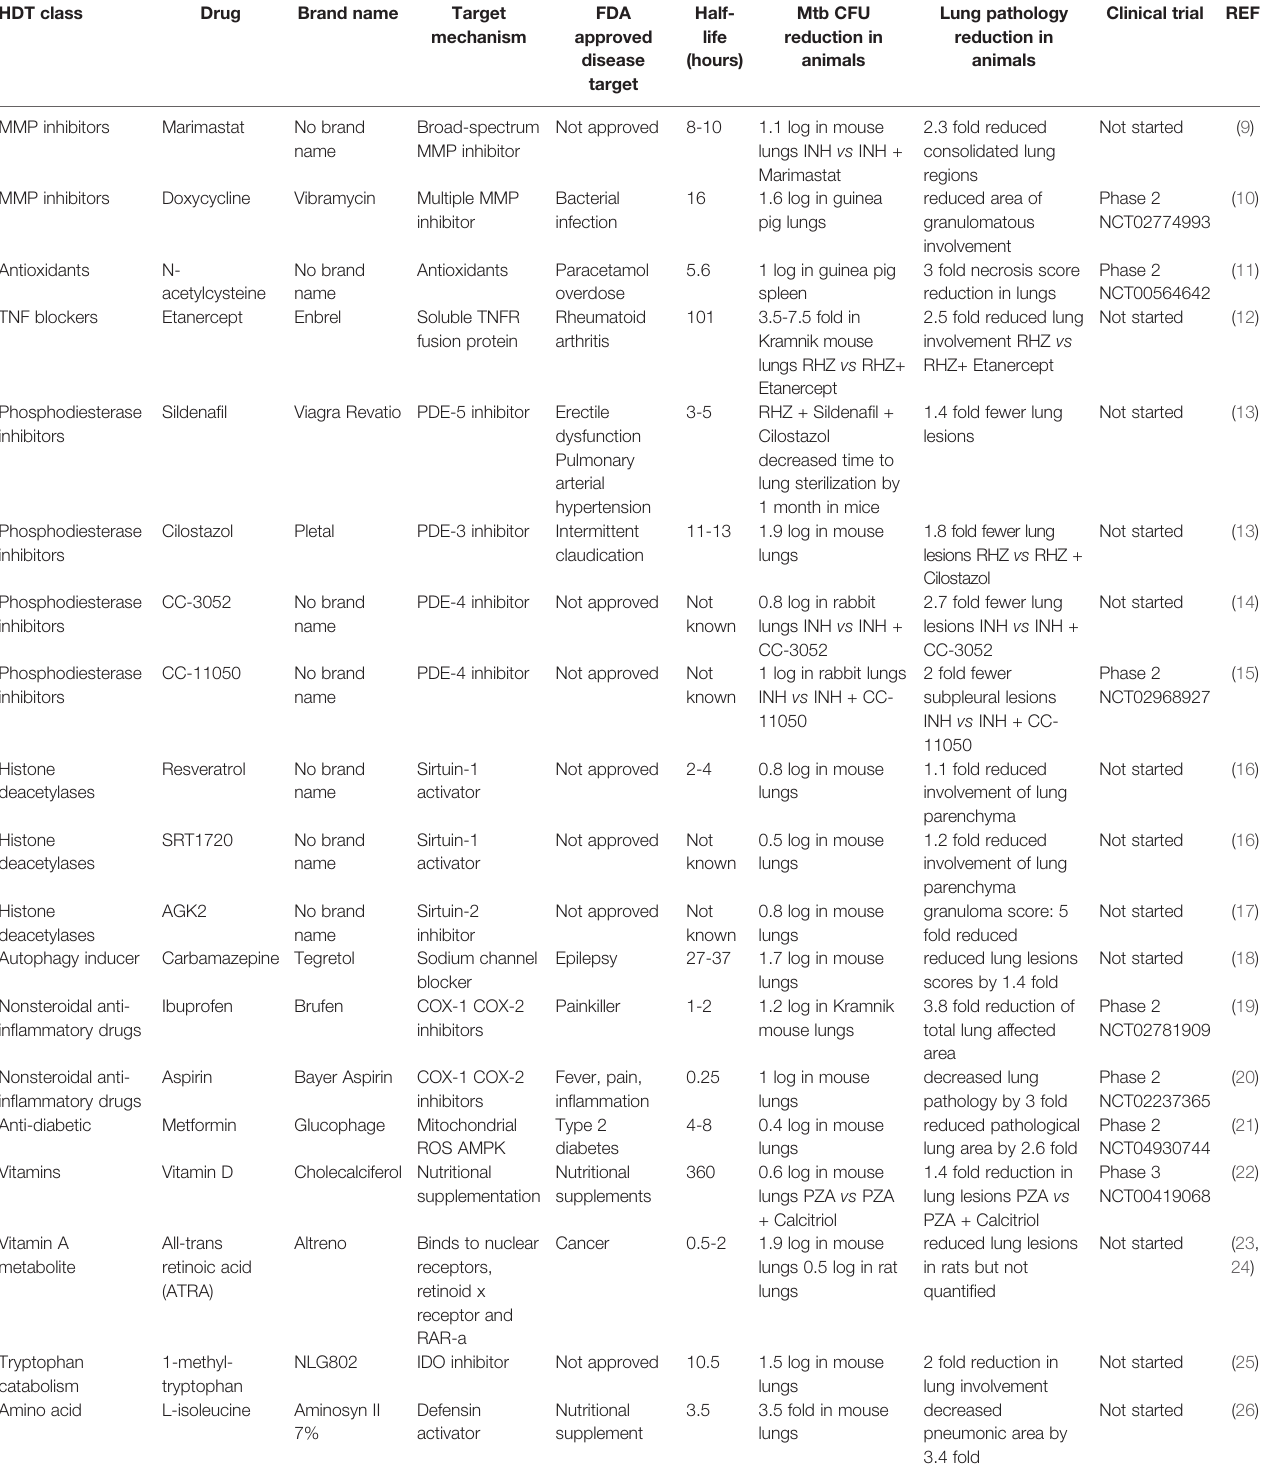
TABLE 1 | List of host speci fi c FDA-approved drugs and inhibitors that were demonstrated in pre-clinical animal studies to have immunomodulatory activities decreasing the mycobacterial burden and dampening lung pathology (fold changes were extracted by using GetData Graph